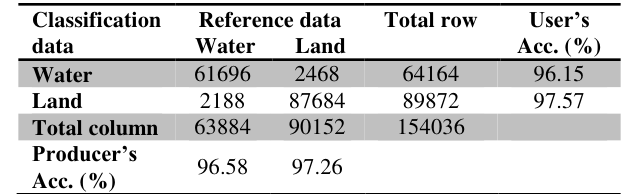
Figure 10. NDFI histograms of Site